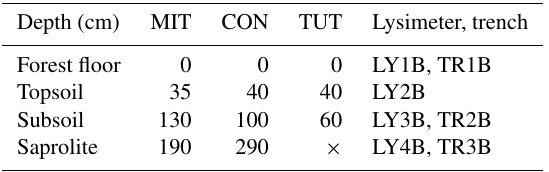
Table 2. Depth (cm) of lysimeter (LY) and trench (TR) installations aligned with the main soil horizons for Mitterfels (MIT), Convent- wald (CON) and Tuttlingen (TUT). “B” indicates the sprinkling plot and is used to be consistent with other publications from the same sites, and × indicates that LY4B and TR3B could not be installed at TUT due to shallow soil